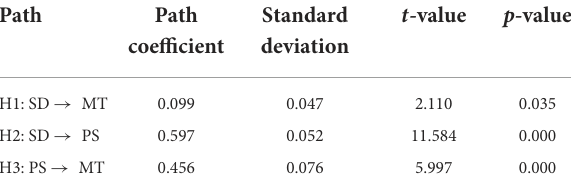
TABLE 5 Regression